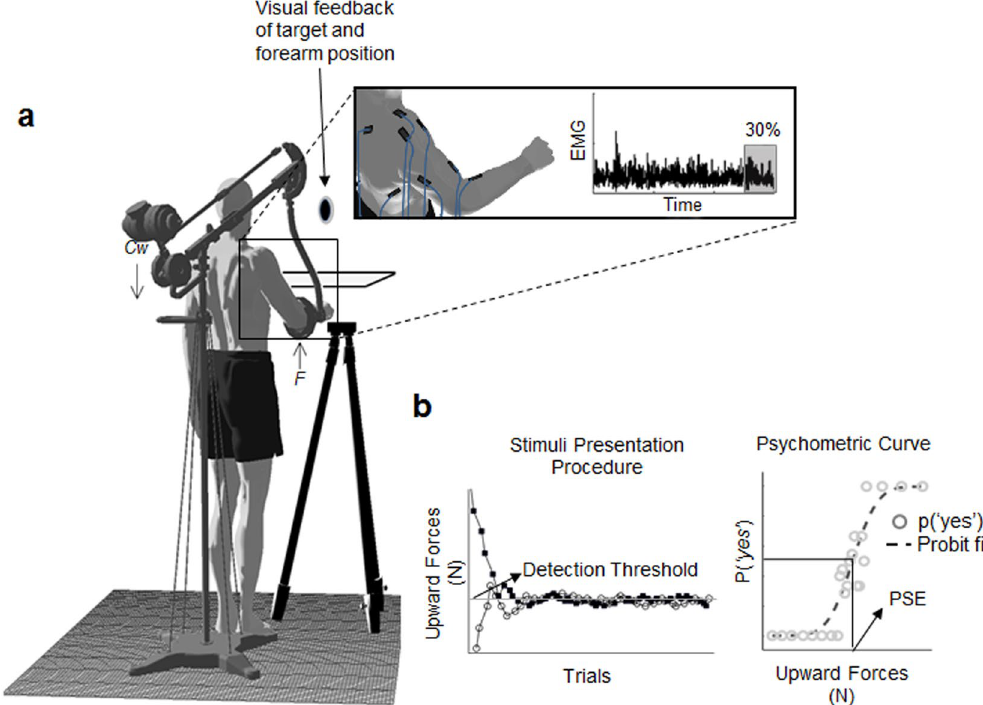
Figure 1. Apparatus. ( a ) Track-hold (TH) device and participants’ arm posture at the moment of force application, i.e., cursor aligned with the target sphere and arm posture not exceeding 5.0° from the initial arm configuration (see apparatus section). Cw : load applied on TH balancer. F : resultant upward force applied on participants’ arm. The inset shows the eight electrodes applied on forearm and upper arm muscles: brachio- radialis, biceps brachii, long head, triceps brachii, long head; trapezius upper; trapezius middle; latissimus dorsi; deltoid, anterior and deltoid, posterior. The EMG dataset considered for the analysis was composed of the last 30% of each trial total duration. b ) left: Double staircase force presentation procedure. White and black circles and markers represents the ascending and descending staircase, respectively. Horizontal line indicate the force intensity where the two stairs converged. Right: probabilities of detection (circles) and probit curve fit. PSE was calculated as the force intensity eliciting 50% of probabilities of answer